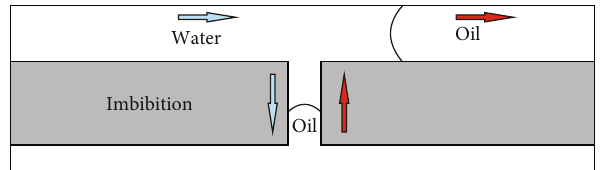
Figure 12: Schematic diagram of imbibition in the multistage seepage